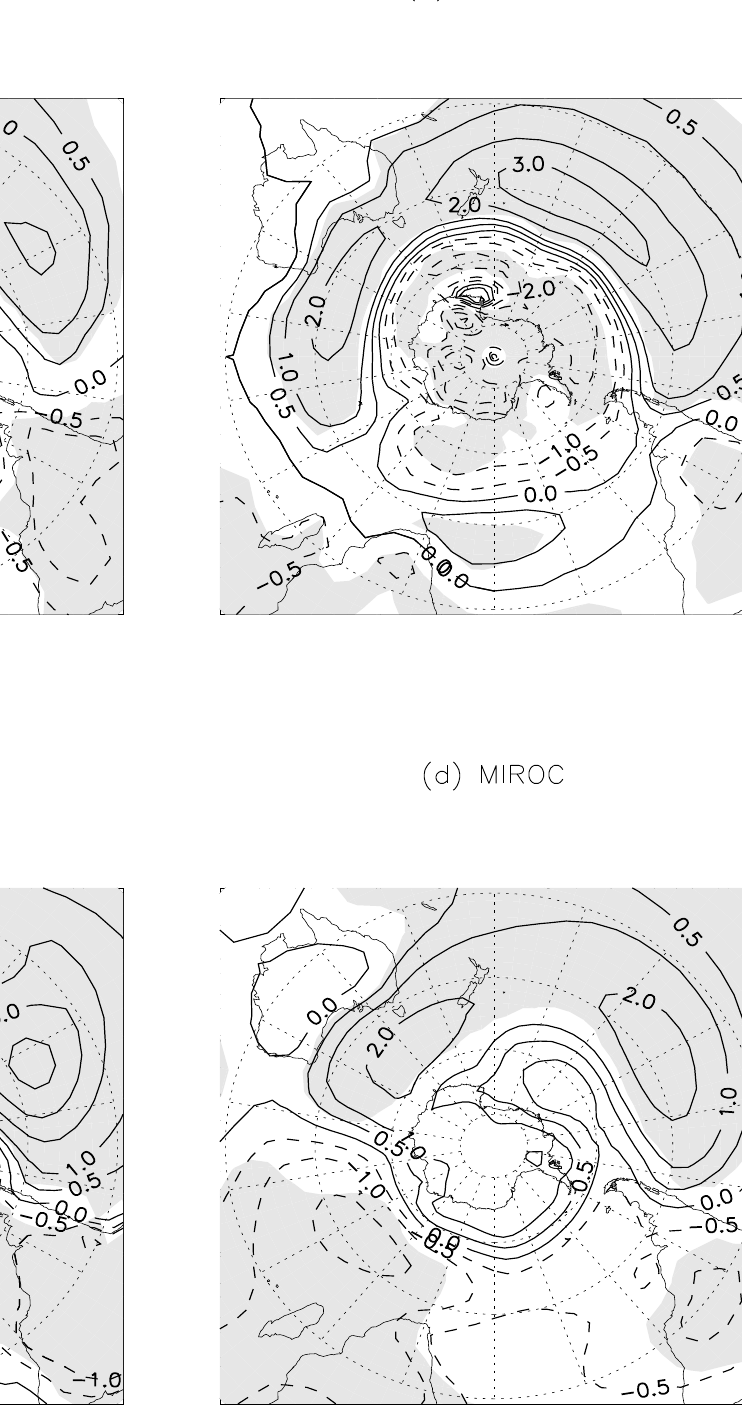
Fig. 6. The same as Fig. 3 except for SON